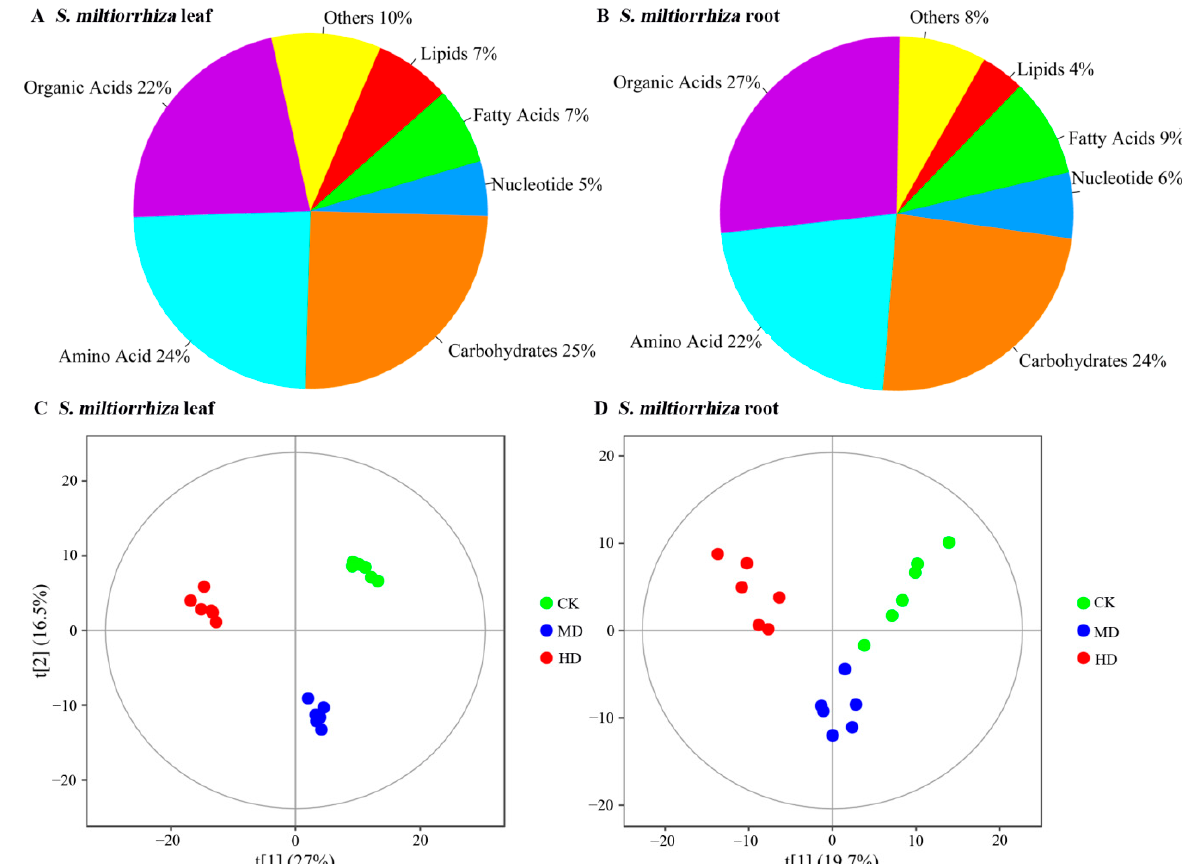
Figure 1. Overview of the metabolites in Salvia miltiorrhiza Bunge leaf and root. ( A , B ): The pie chart indicating the distribution of annotated metabolites. ( C , D ): The results of the partial least squares discrimination analysis (PLS-DA) of analyzed samples. MD: moderate drought. HD: high (severe) drought. CK: control.